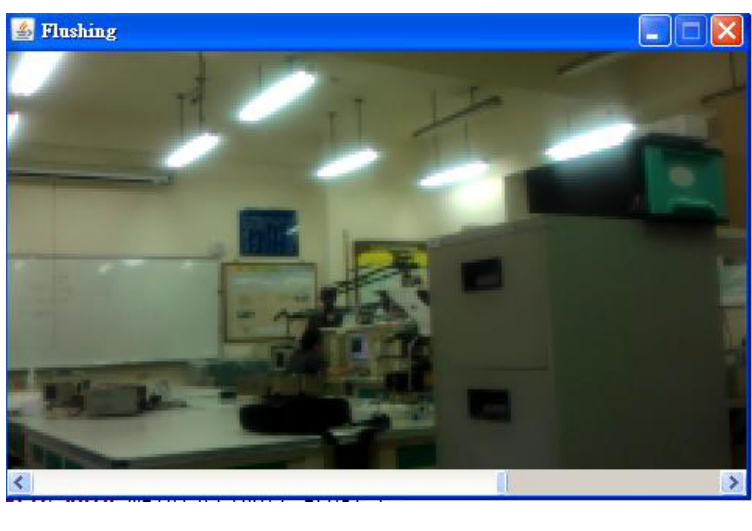
Figure 10. The real-time image on the server